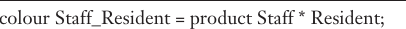
Table 2. colour Resident = with Novice Experienced timed; Colour sets used colour Staff = with Staff timed; in the colour Staff_Resident = product Staff * Resident;